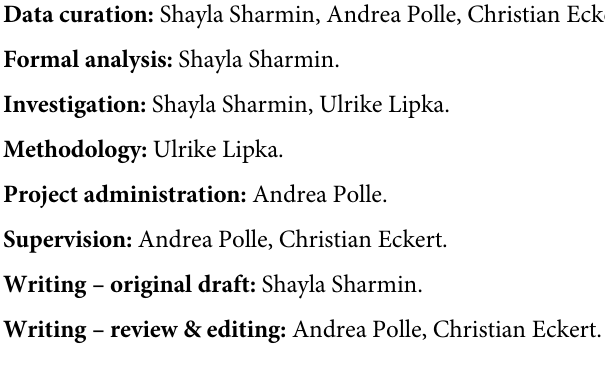
S4 Table. Concentration of different elements measured in the leaf of P . × canescens plant grown under different treatments. Values represent means ± SE (n = 5 or 10). One-way ANOVA was conducted in case of each element. Normal distribution of data was tested by plotting residuals and log transformation was used for certain cases (Na and Fe) to meet these criteria. Homogeneous subsets were found after Fisher’s test. Different lowercase letters in a column indicate significant differences at p < 0.05. S5 Table. Ratios of Na/K, Na/Ca, Na/Mg, Na/Mn, Na/Fe, Na/P and Na/S of in the leaf tissue of P . × canescens plant grown under different treatments. The ratio was calculated from concentration (mg g -1 dry mass) values of the elements. Values represent means ± SE (n = 5 or 10). One-way ANOVA was conducted in every case. Normal distribution of data was tested by plotting residuals and log transformation was used in each case to meet these criteria. Homo- geneous subsets were found after Fisher’s test. Different lowercase letters in a column indicate significant differences at p < 0.05. S6 Table. Relative concentration of Mn, S and P in the cortex and the vascular tissues of root of P . × canescens according to EDX analysis. Data represent mean ± SE (n = 3 or 4) (four measurements were taken from each plant). Two—way ANOVA was conducted for each element with treatment and tissue as two main factors. Beta regression model was used for ANOVA and homogenous subsets were found with Fisher´s test. Different lowercase letters in the column of specific element for both tissues indicate significant differences among treat- ments at p <